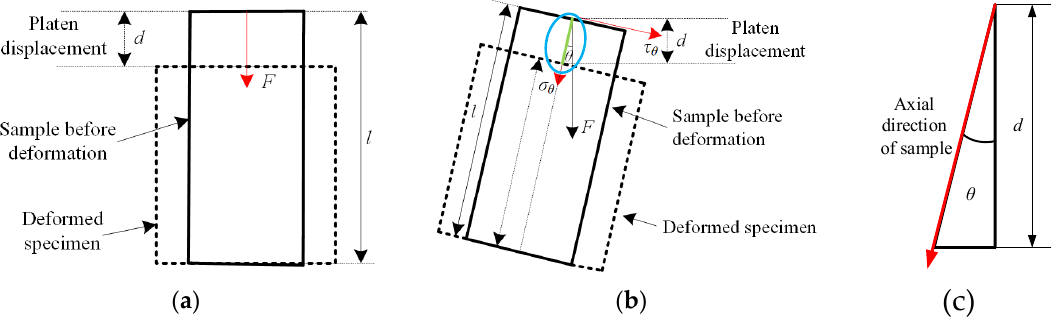
Figure 4. Stress and deformation characteristics of samples before and after the test: ( a ) Traditional uniaxial compression strength (UCS) test; ( b ) Inclined UCS test; ( c ) Local enlarged view in (b).